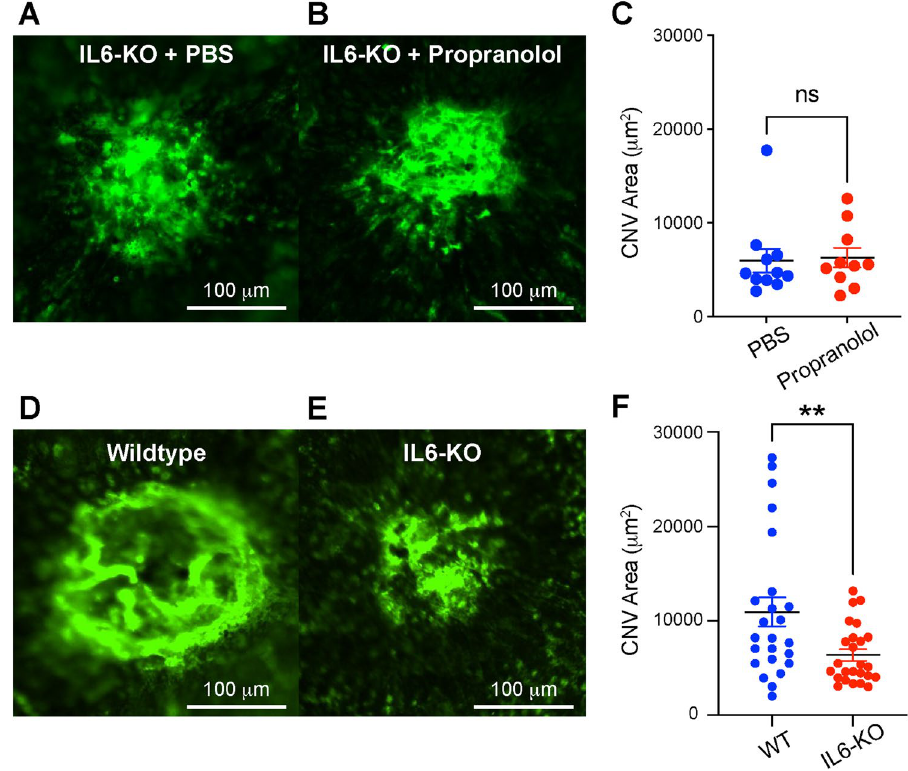
Figure 2. IL6 is necessary for CNV. Representative immunofluorescence staining of CNV lesions in PBS ( A ) and propranolol ( B ) treated Il6 −/− mice. Propranolol had no effect upon CNV area in IL6-null mice (ns = not significant, N = 10–11 per group, C). Representative immunofluorescence staining of CNV lesions in wildtype (D) and Il6 −/− (E) mice. IL6-deficiency resulted in a 42% decrease in CNV area (** = p < 0.01, N = 24–25 per group, F).